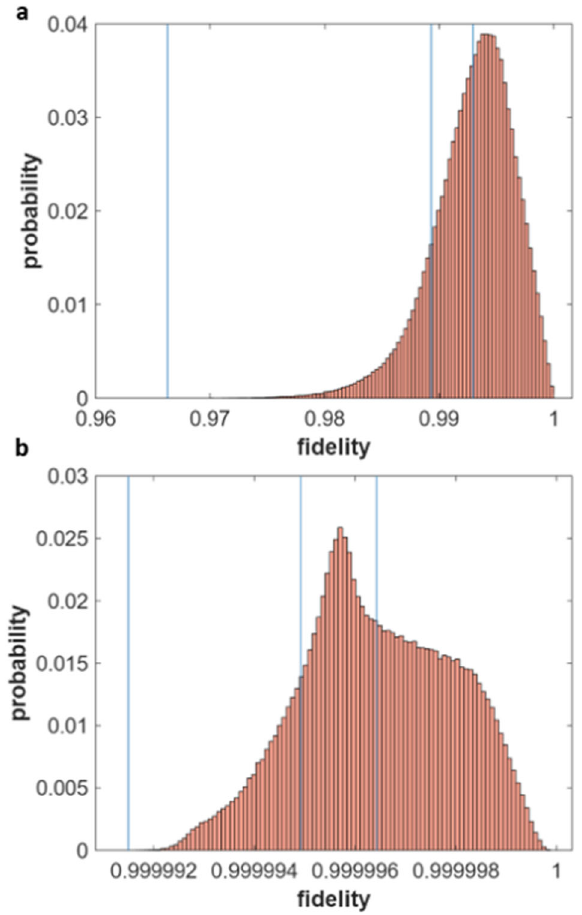
Fig. 6 Two-step optimisation. Fidelity distribution in the hypercube for the Hadamard gate at 5% uncertainty in the control amplitude and the coupling (last row of Table 1). a Distribution after the centre optimisation of step 1 (see text). b Distribution after the extreme- point optimisation of step 2. The three lines indicate, from left to right, the minimum fi delity at the extreme points, the fi delity at one standard deviation below the average fi delity, and the average fi